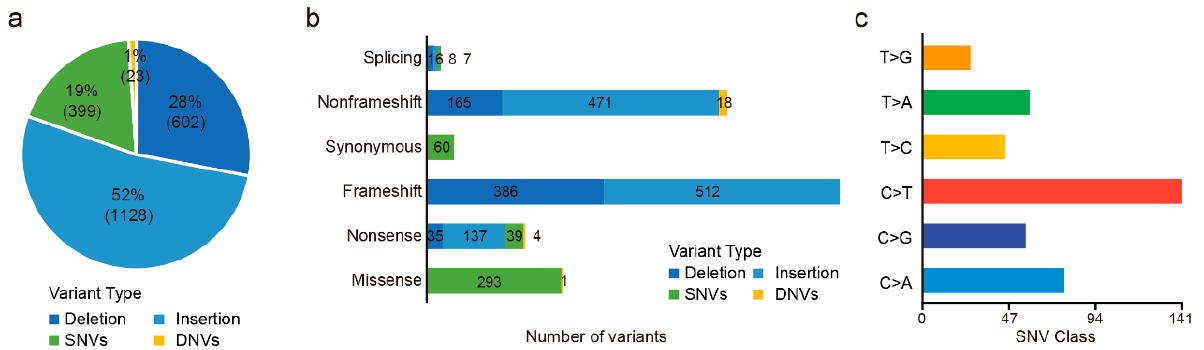
Figure 1. Outcomes of variants calling in 72 CCA patients. ( a ) Percentage of SNVs, DNVs, and indels. ( b ) Numbers of missense, nonsense, synonymous, frameshift, nonframeshift, and splicing variants. ( c ) Numbers of each SNV class.